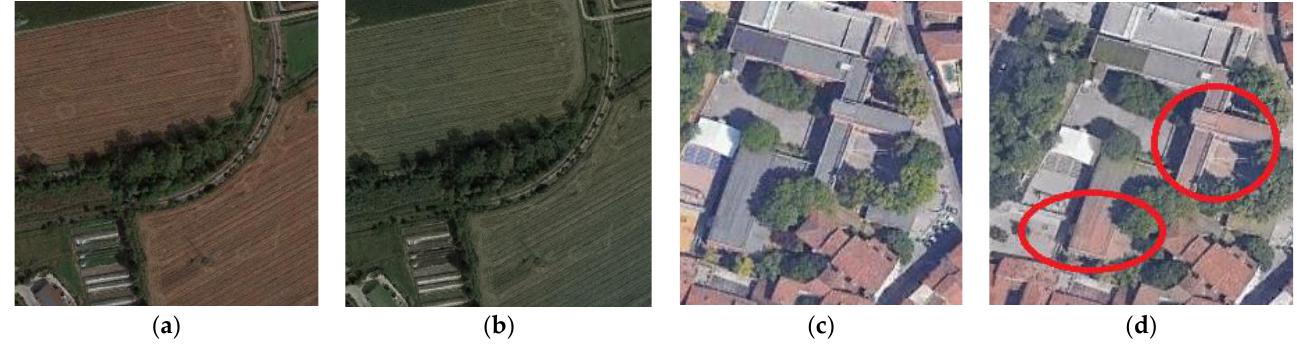
Figure 6. Reference actual aerial images converted in grayscale and used in our colorization tests ( a , c ) and examples of incorrect prediction ( b ) and ambiguities ( d ) using the U-NET model.